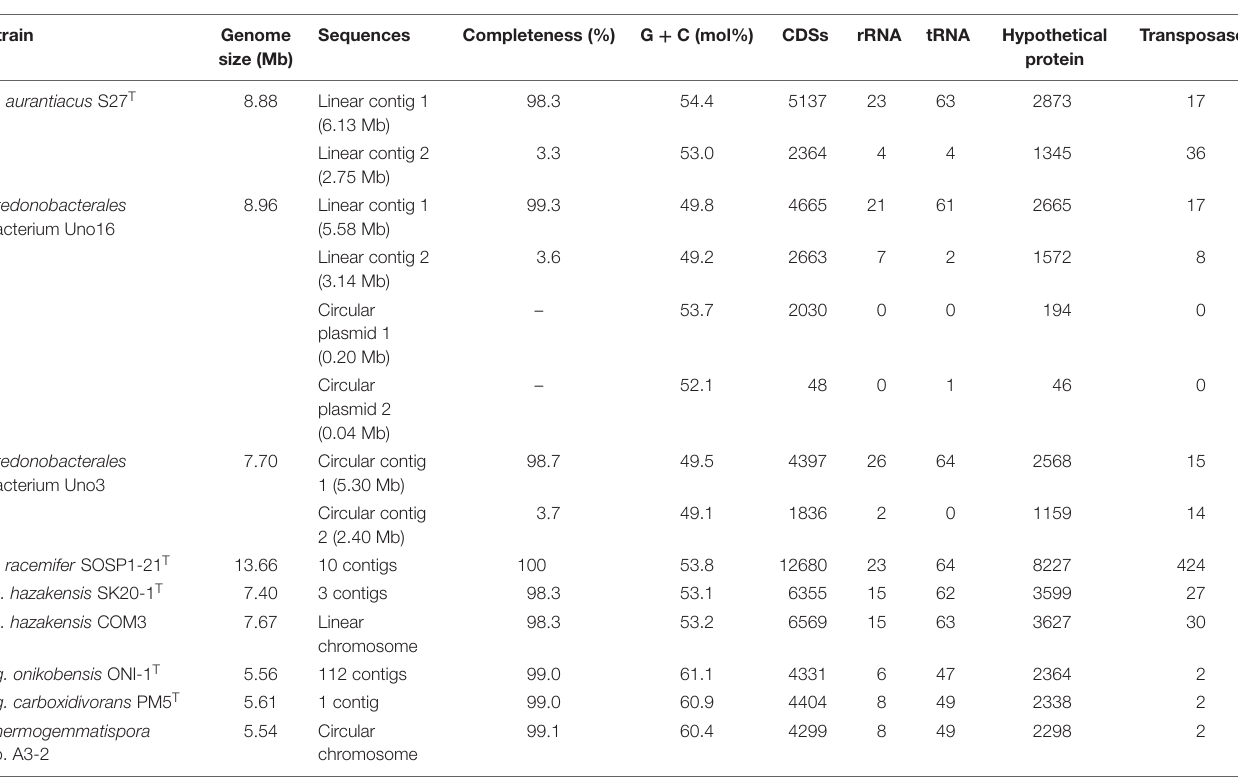
TABLE 2 | General genome features of the nine studied Ktedonobacteria